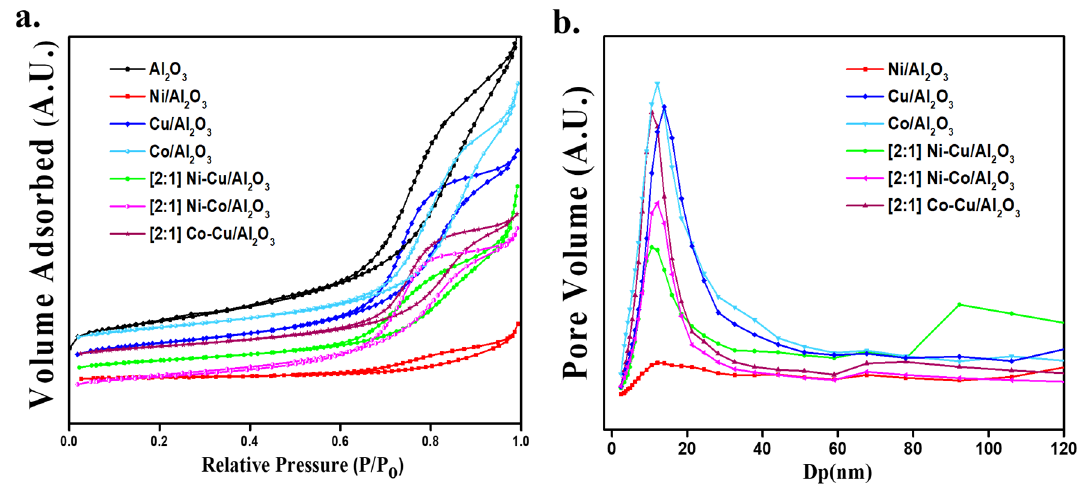
Figure 1. N 2 adsorption–desorption isotherms ( a ) and Barrett–Joyner–Halenda (BJH) pore size distribution ( b ) of the monometallic and bimetallic catalysts.